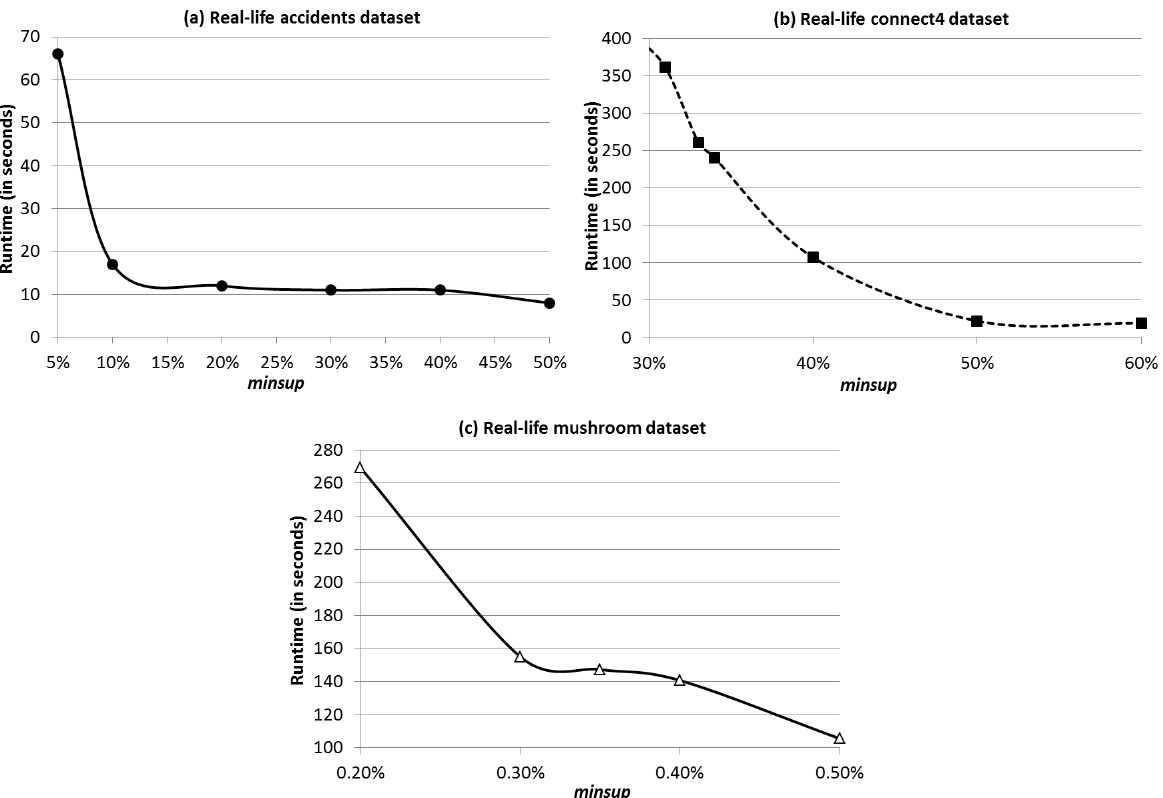
Figure 4. Runtime vs. minsup on ( a ) accidents; ( b ) connect4; and ( c ) mushroom